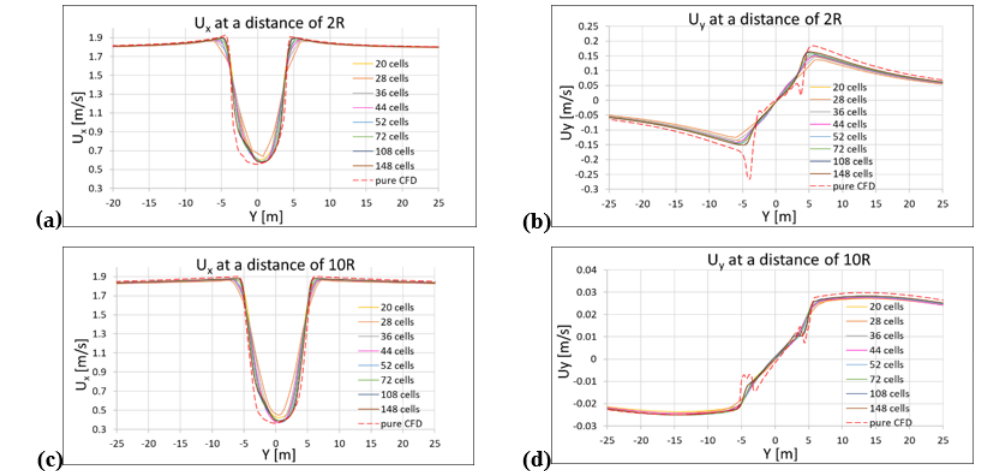
Figure 6. Wake velocity profile at 2R, ( a ) x velocity and ( b ) y velocity and at 10R behind the turbine ( c ) x velocity and ( d ) y velocity.